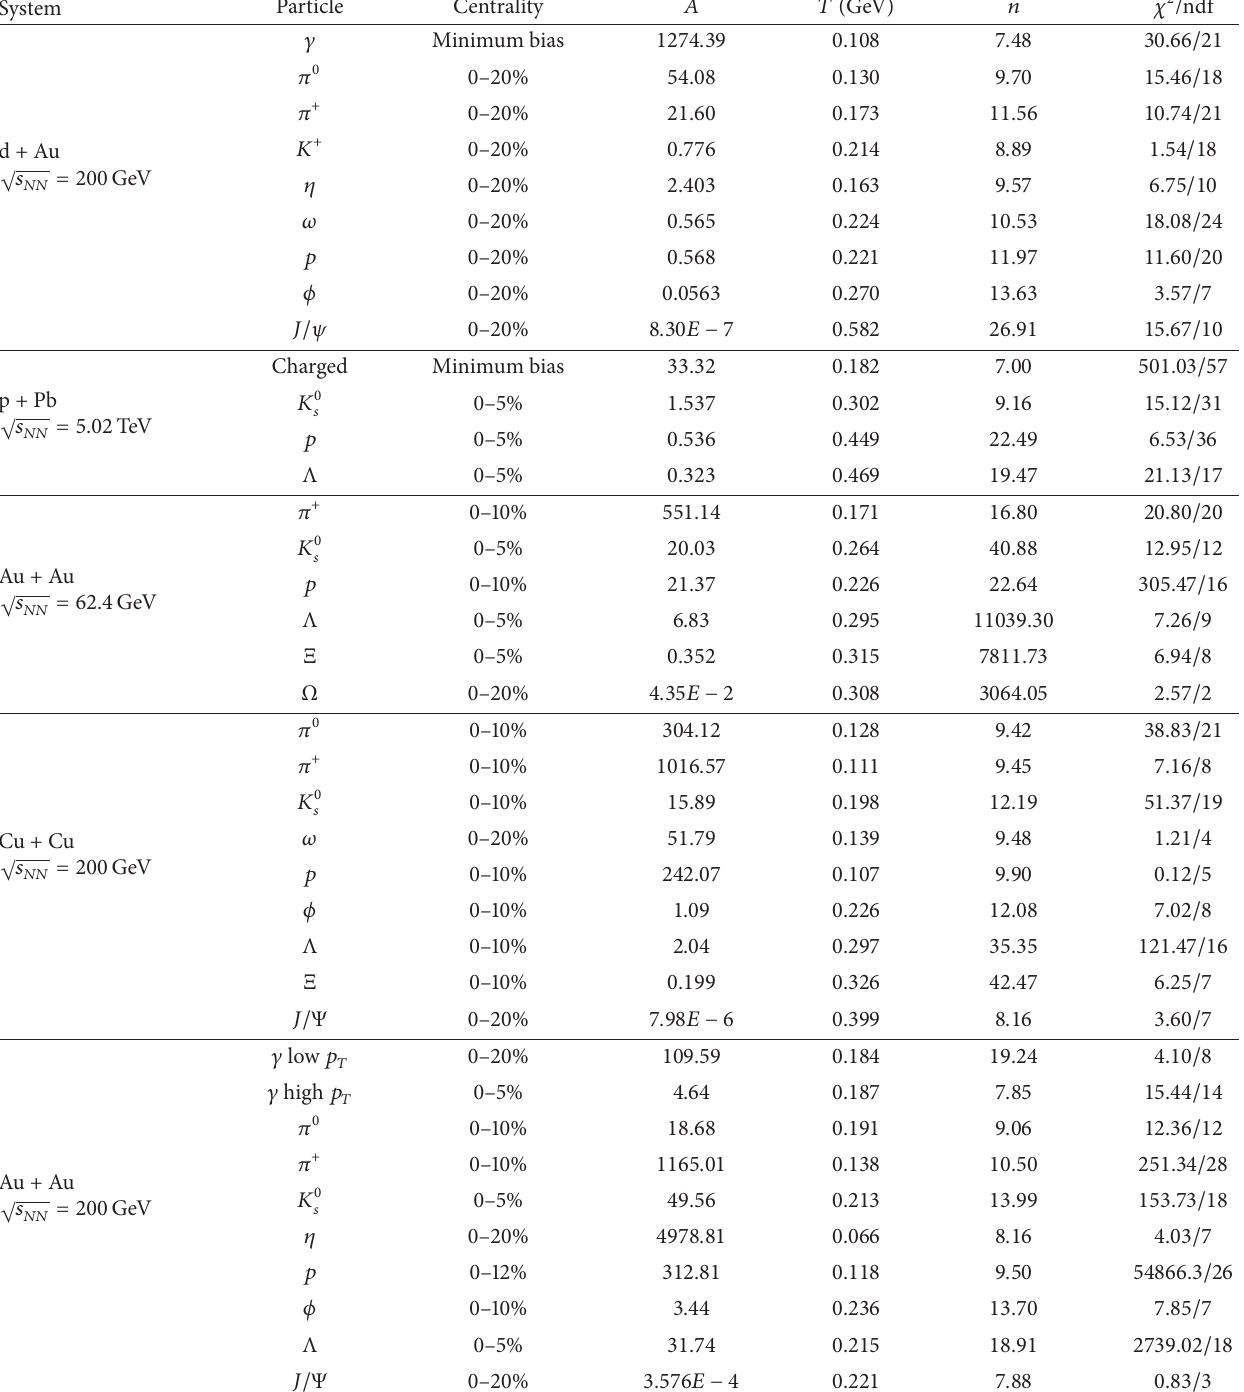
Table 1: The fitting parameters and the corresponding 𝜒 2 /ndf for various particles in different collision systems with Tsallis distribution Equation